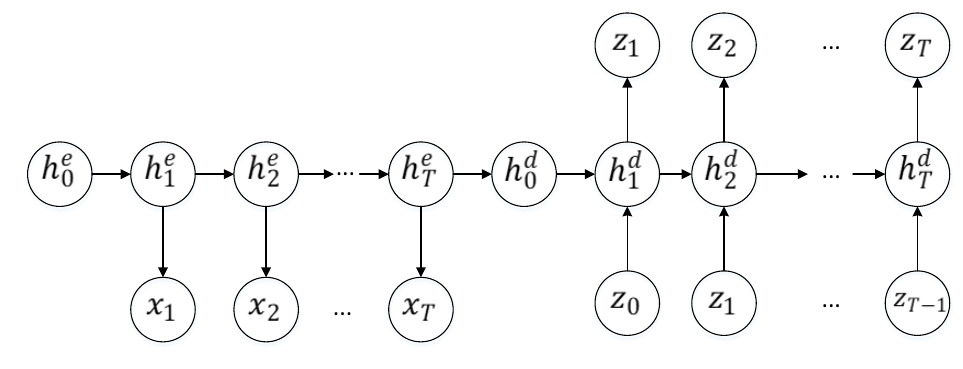
Figure 7. A recurrent autoencoder